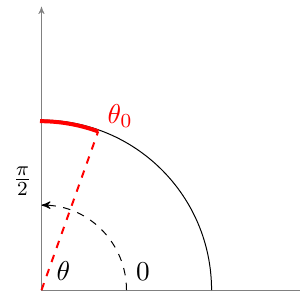
Figure 5 . Comparison of a distribution of giant gravitons (superstar) wrapping all 3-cycles of the 5-sphere (left) with a localised superstar wrapping 3-cycles in the interval (cid:18) 2 [ (cid:18) 0 ; (cid:25)